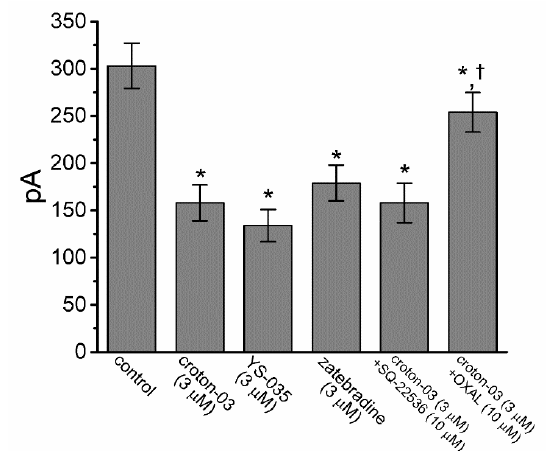
Figure 4. Comparisons among effects of croton-03, YS-035, zatebradine, croton-03 plus SQ-22536 and croton-03 plus oxaliplatin (OXAL) on I h amplitude recorded from GH 3 cells. Cells were bathed in Ca 2+ - free Tyrode’s solution and the hyperpolarizing potential from −40 to −110 mV with a duration of 2 sec was applied to the cell. I h amplitude was measured at the end of hyperpolarizing pulse in the presence of different tested compounds. Each bar indicates the mean±SEM ( n = 7–9). * Significantly different from control ( p < 0.05) and † significantly different from croton-03 (3 μM) along group ( p < 0.05).